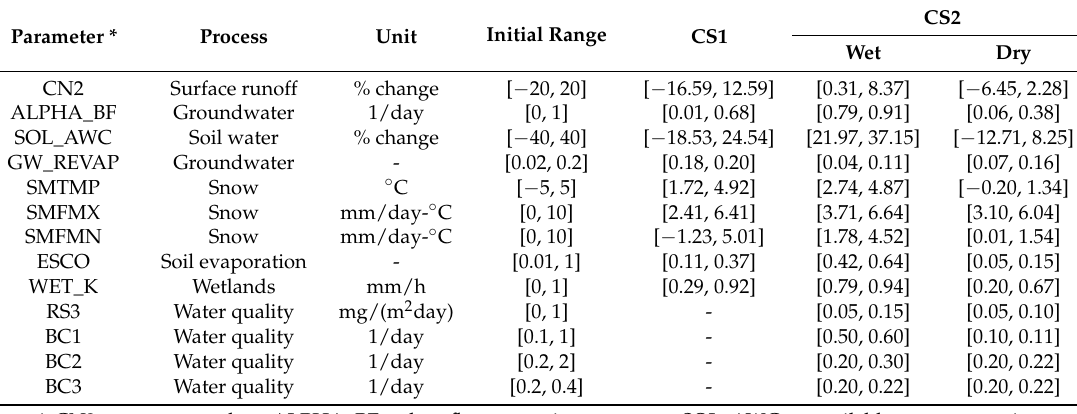
Table 3. Water quantity and quality parameters for different calibration schemes (CS1: traditional calibration scheme; CS2: wet-dry calibration